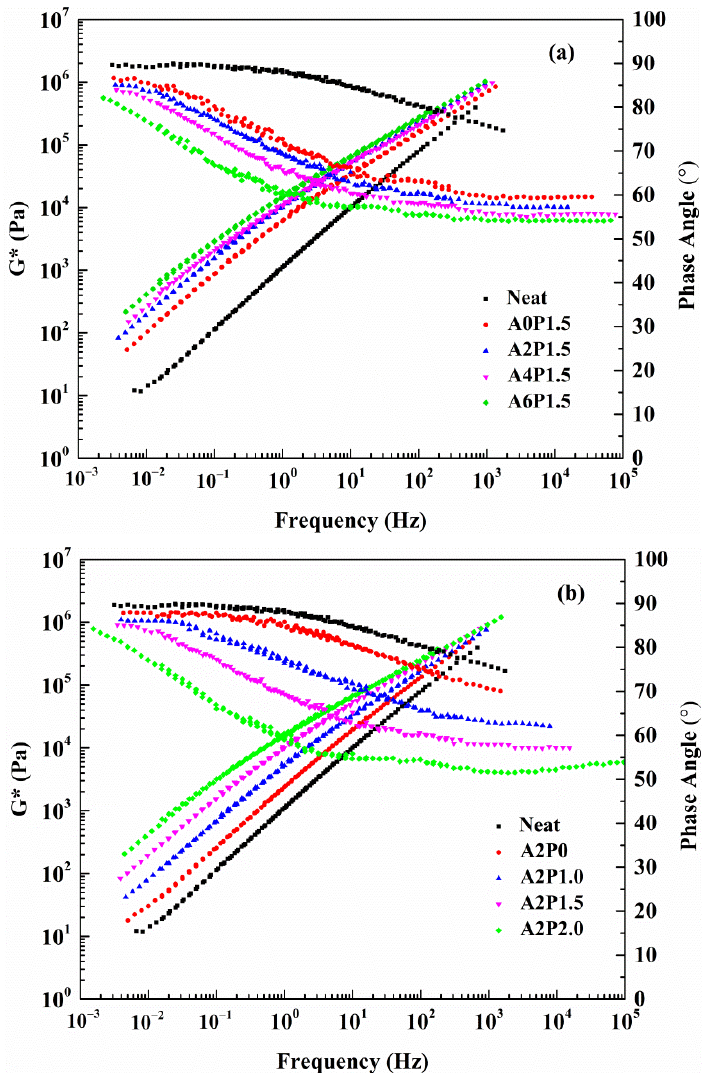
Figure 5. Complex modulus and phase angle master curves of composite modified binders: ( a ) composite modified binders with various contents of APAO; ( b ) composite modified binders with various contents of PPA.